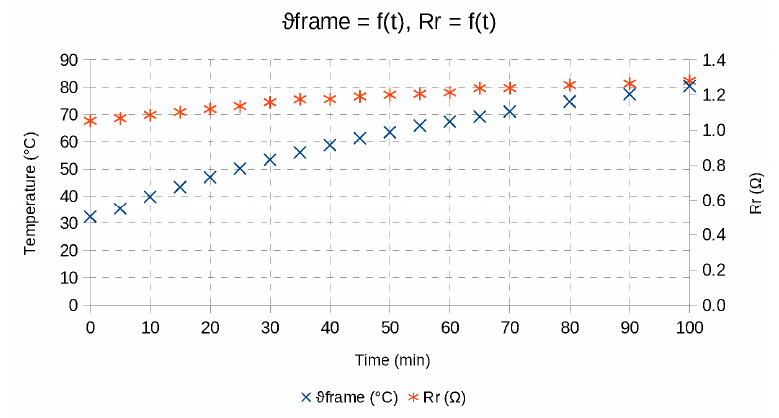
Figure 5. R r and machine frame temperature ϑ frame change during warming test.